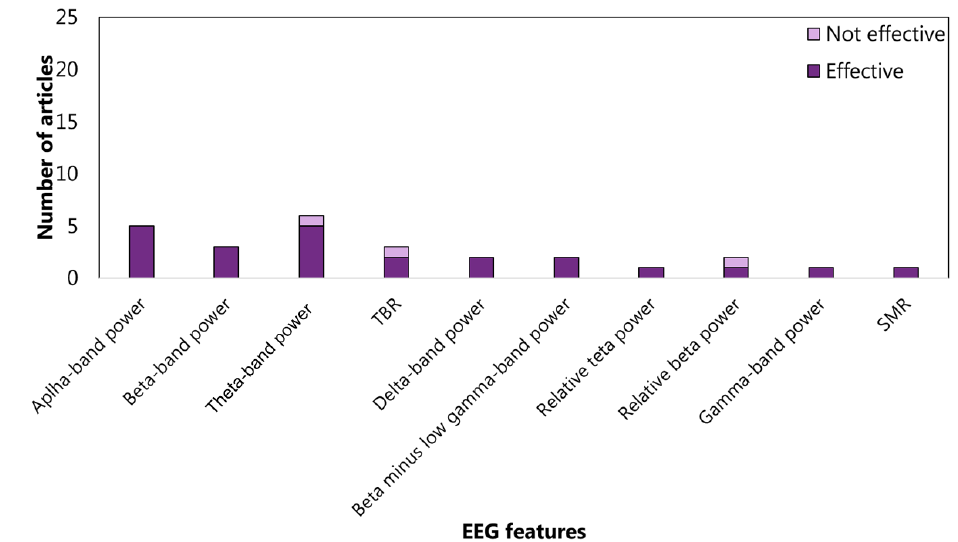
Figure 7. Articles focusing on the relationship between EFs from cluster working memory and EEG features from frequency domain. Theta-band power is the feature most studied: five articles verified (effective) the relationship. TBR: theta–beta ratio; SMR: senso-motor rhythm.